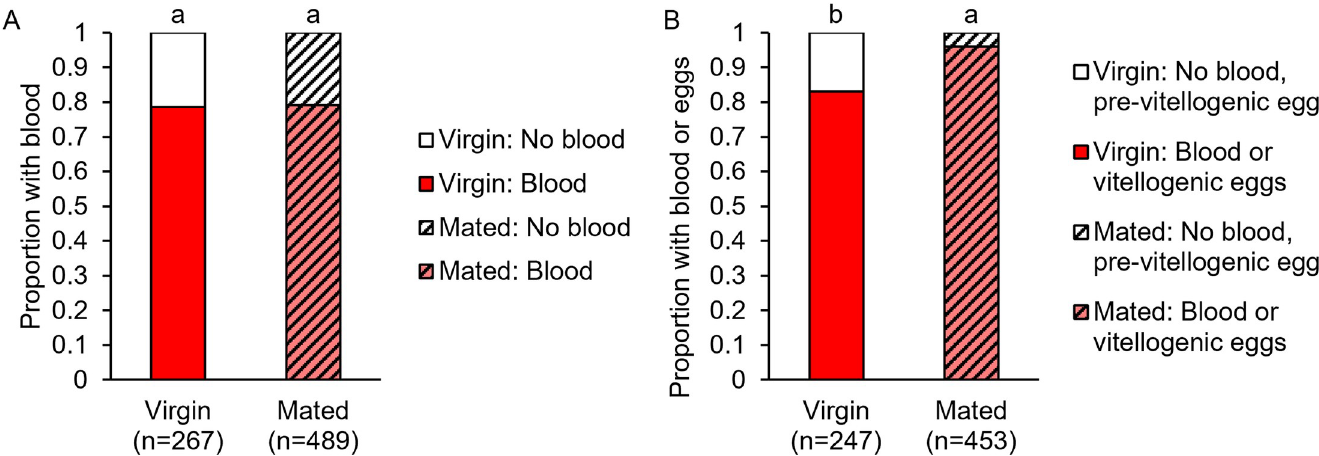
Fig 6. Virgin and mated females collected from natural urban field settings contained blood at similar proportions but differed in reproductive life history. (A) Virgin and mated females collected resting inside houses in Medellı´n, Colombia were equally likely to contain blood in their abdomens. (B) Mated females were more likely than virgins to contain blood or have vitellogenic stage eggs. Letters above columns denote Bonferroni-corrected post-hoc comparison